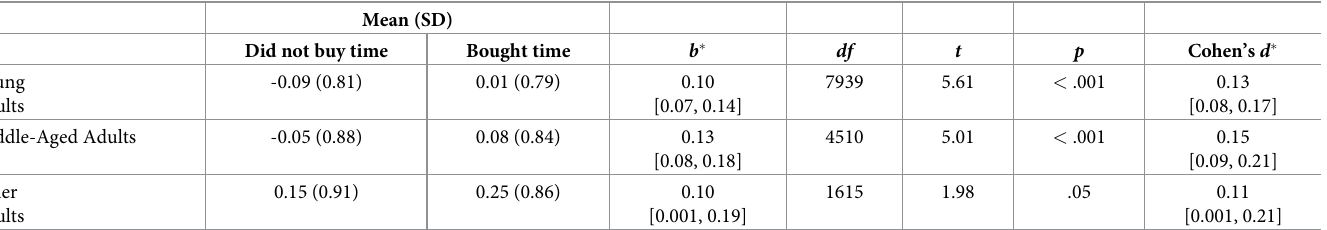
Table 4. The relationship between buying time and SWB by age